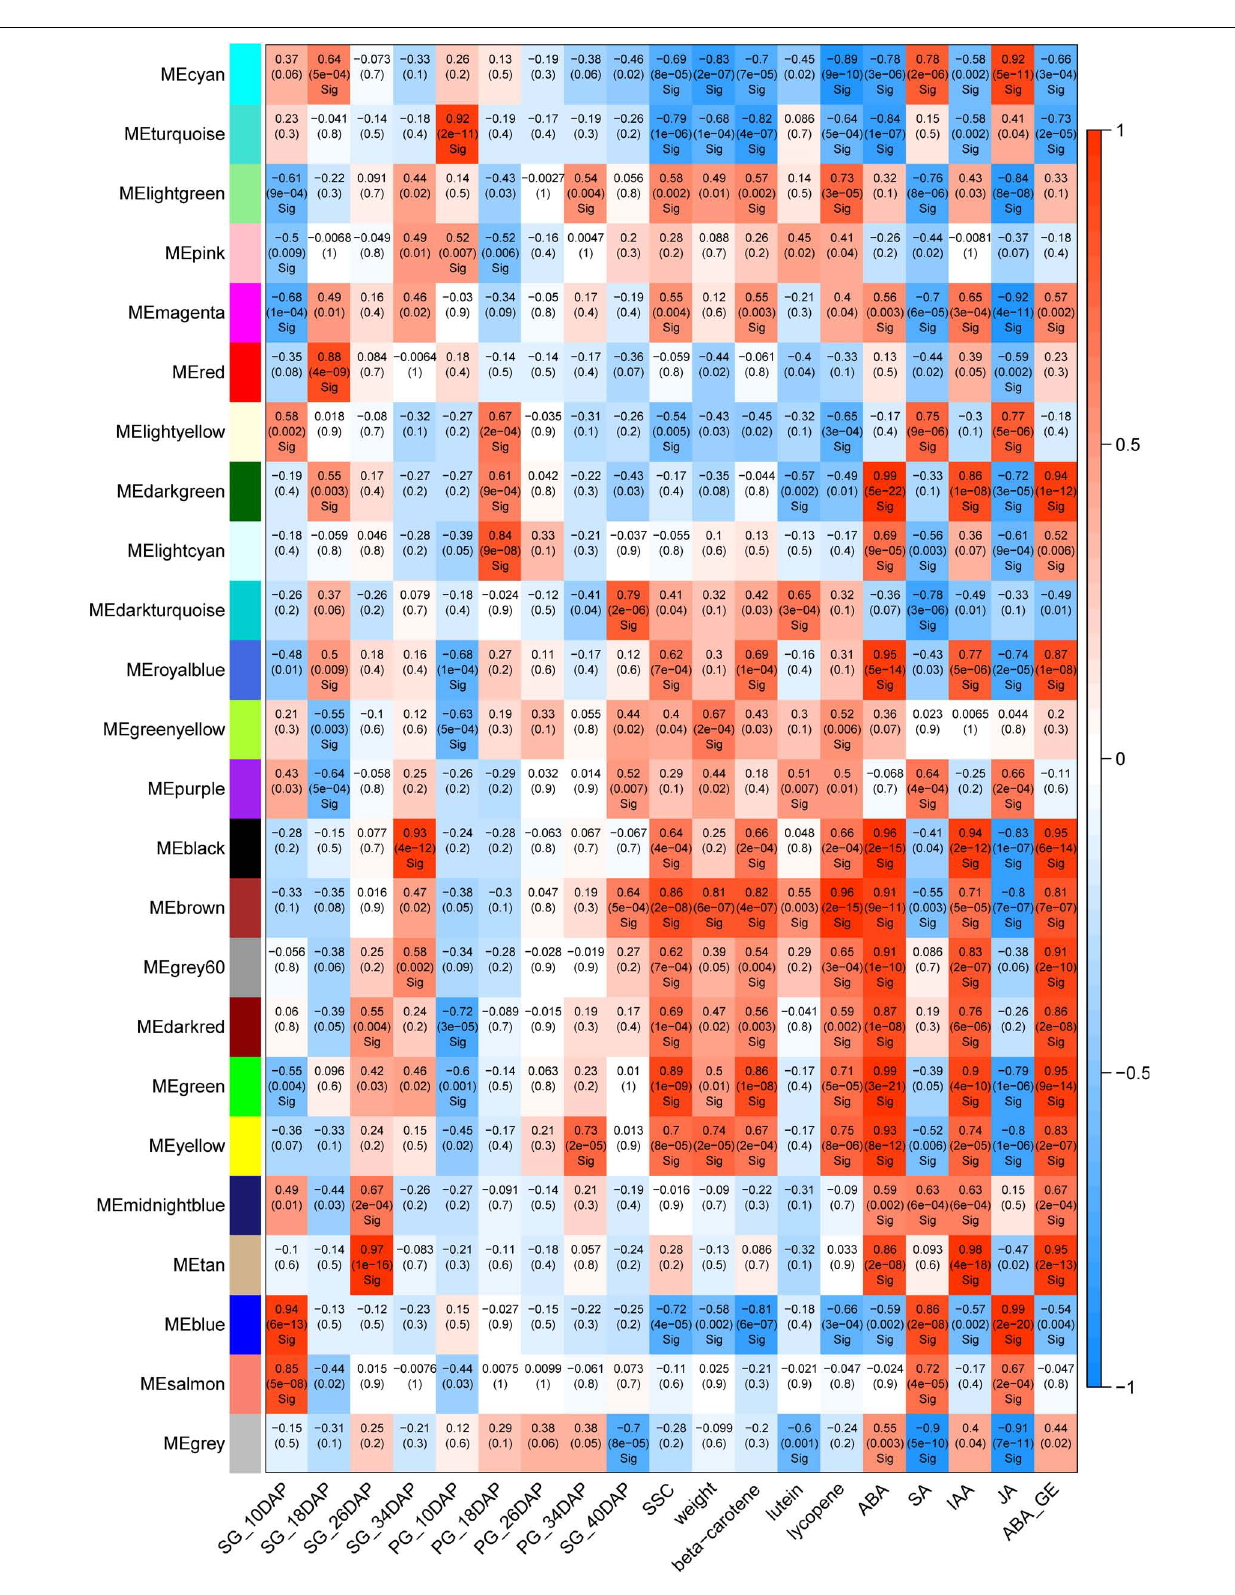
Frontiers in Plant Science |